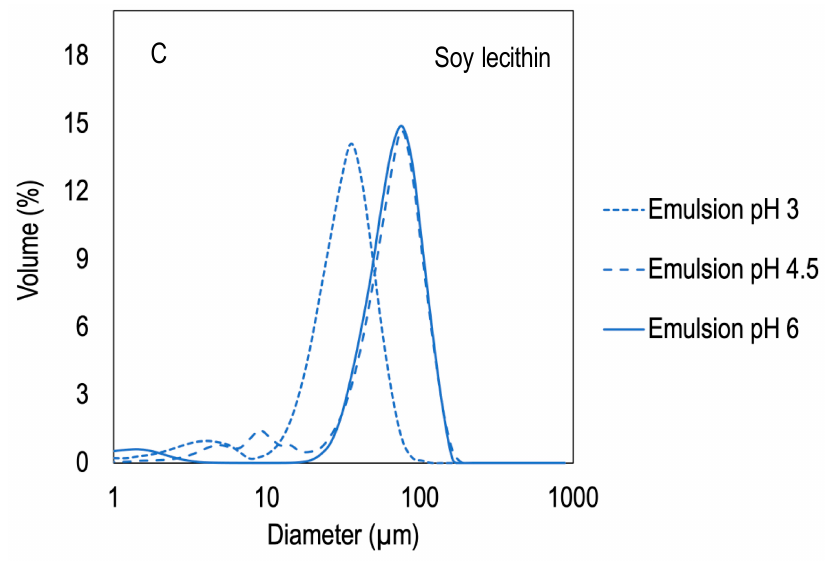
Figure 4. Size distributions of emulsions stabilized by rapeseed proteins precipitated at different pH and soy with varying emulsion pHs, ( A ) Emulsions with rapeseed protein precipitated at pH 3 as emulsifier (RPP3), ( B ) Emulsions with rapeseed protein precipitated at pH 6.5 as emulsifier (RPP6.5). ( C ) Soy lecithin as emulsifier, Protein concentrations in the emulsions were 10 mg protein/mL for the rapeseed formulations and 10 mg/mL oil for the de-oiled lecithin